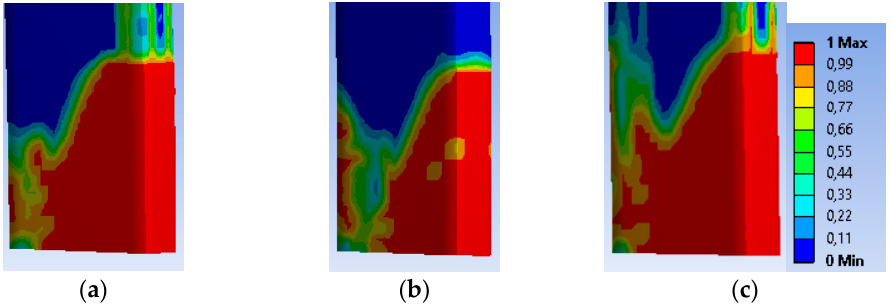
Figure 4. Concrete damage of specimens ( a ) R-P2L0; ( b ) R-P2L1; ( c ) R-P2L3.